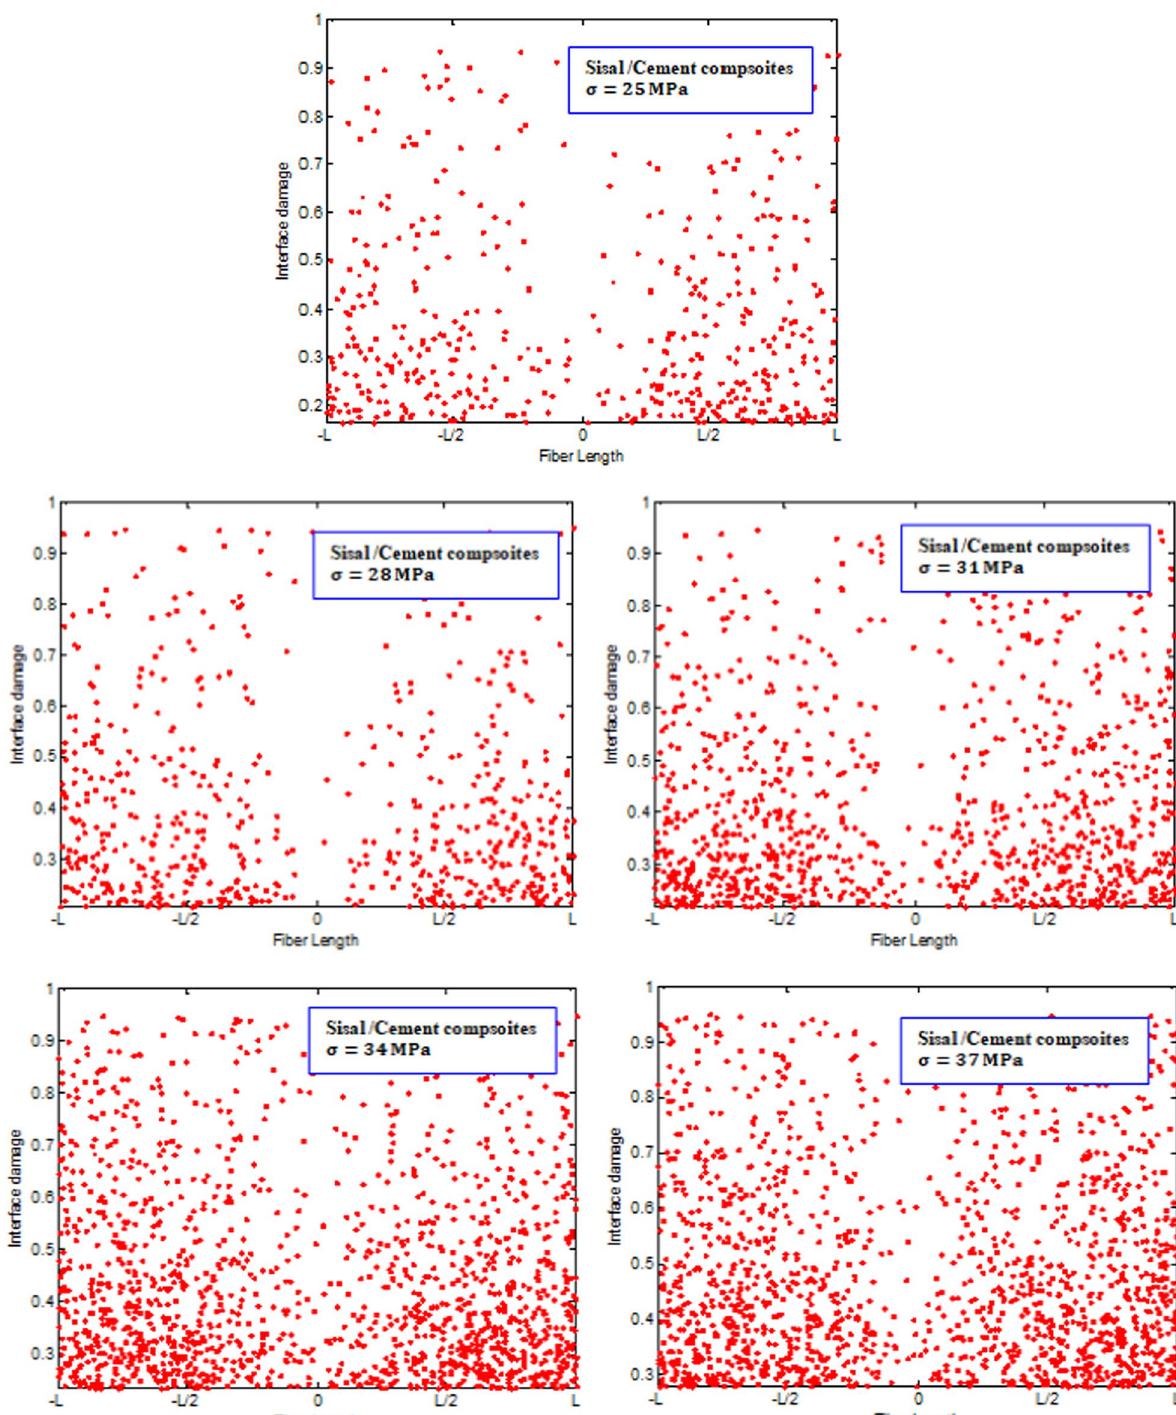
Fig. 7 Fiber-mortar interface damage of Sisal/Cement